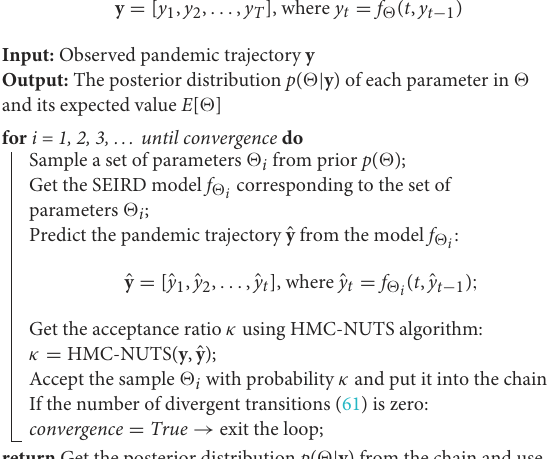
Algorithm 1. Estimating parameters of the SEIRD model using HMC- NUTS